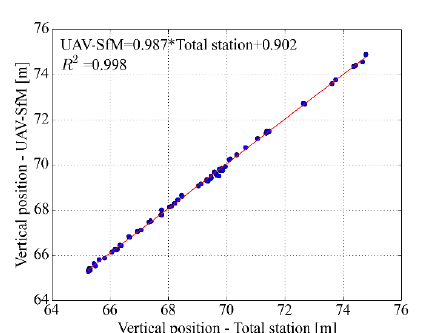
Figure 6. Regression analysis between SfM derived and observed elevations at validation points for Feb16 image